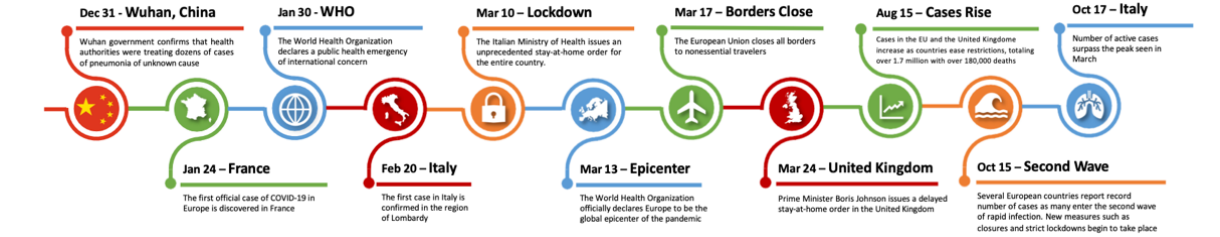
Figure 1. Timeline of COVID-19–related events and decisions made (2020). EU: European Union; WHO: World Health